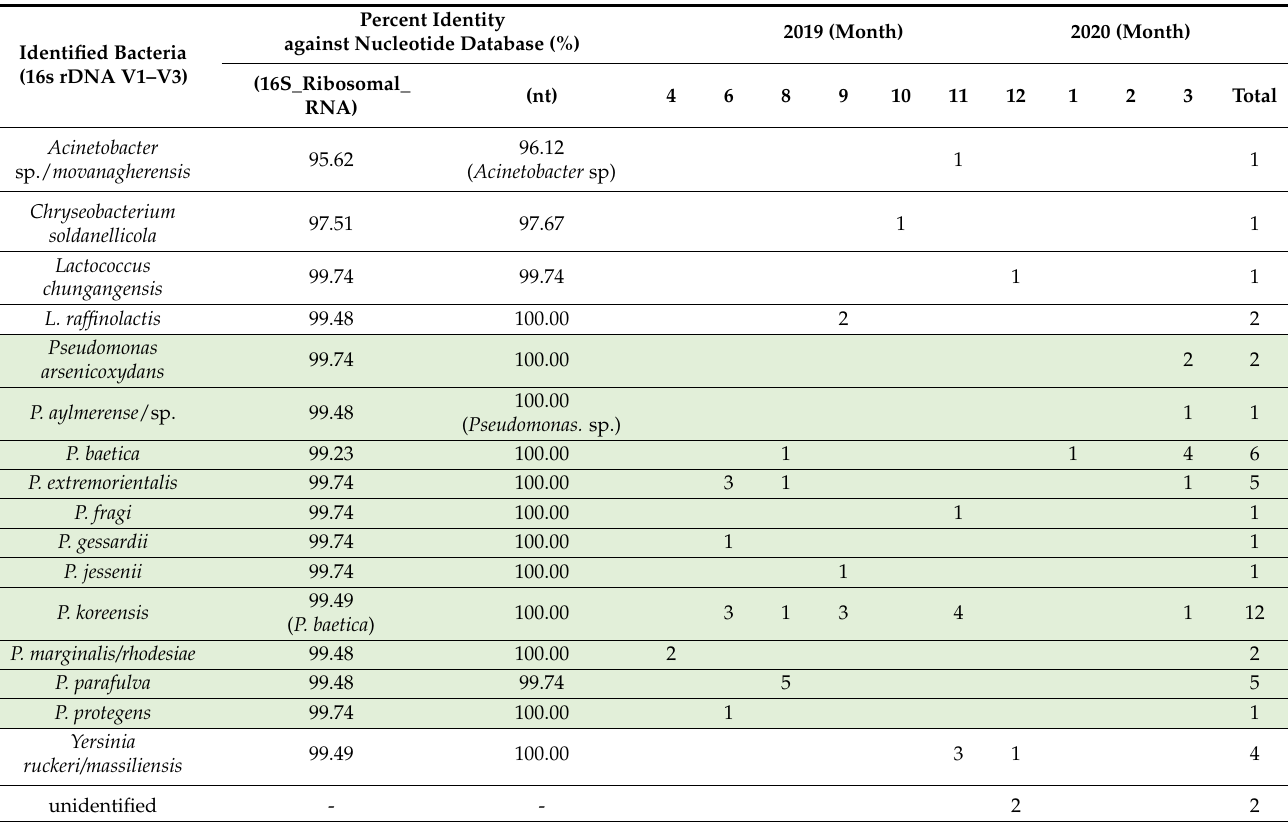
Table 1. The number of isolated bacterial clones with antimicrobial activity identified in the skin mucus layer of rainbow trout in a flow-through aquaculture